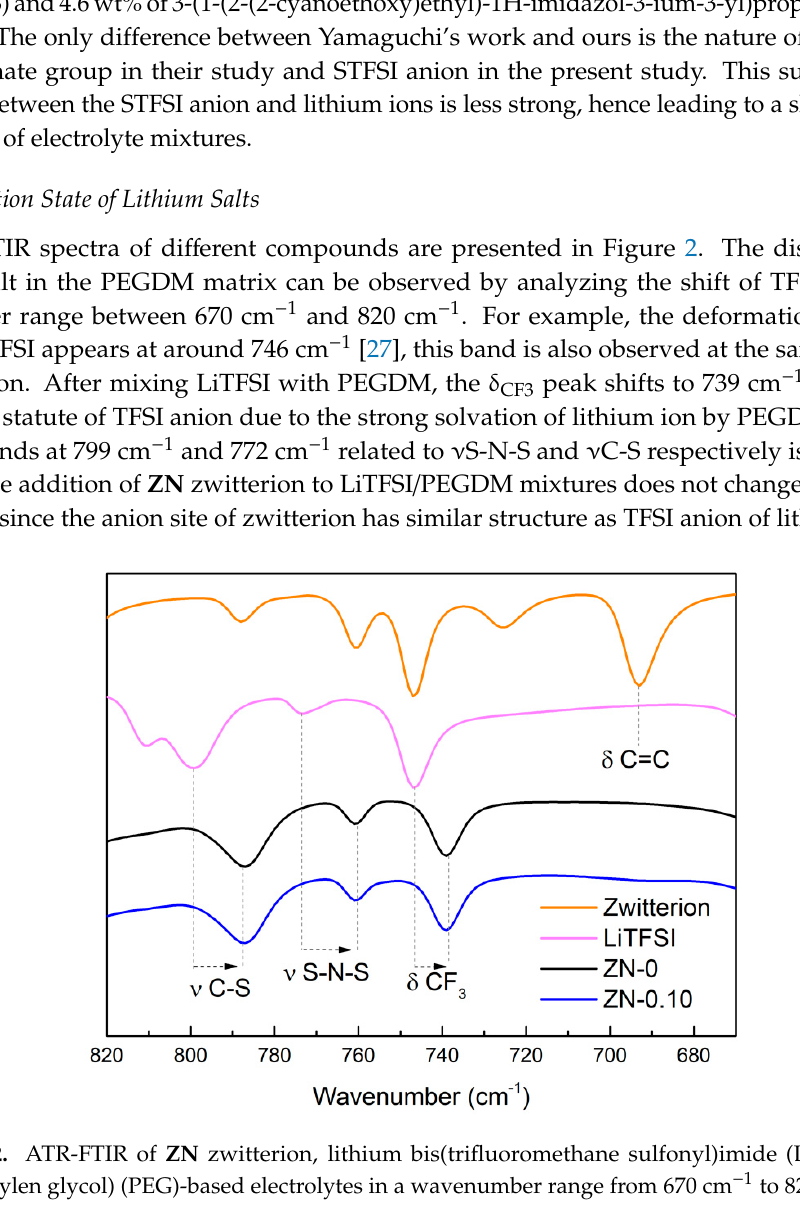
Table 2. Summary of TGA and differential scanning calorimetry (DSC) studies of the ZN molecule and investigated electrolytes.